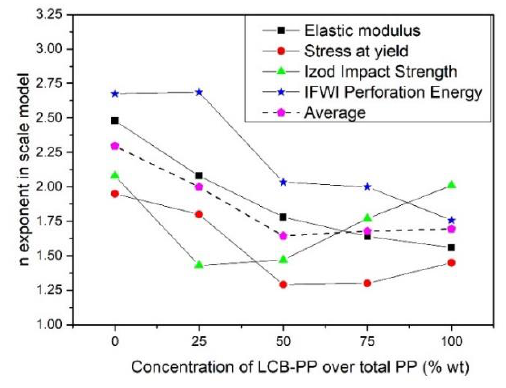
Figure 11. n exponent of each property, following the scale model (Equation (1)). The average is also represented.